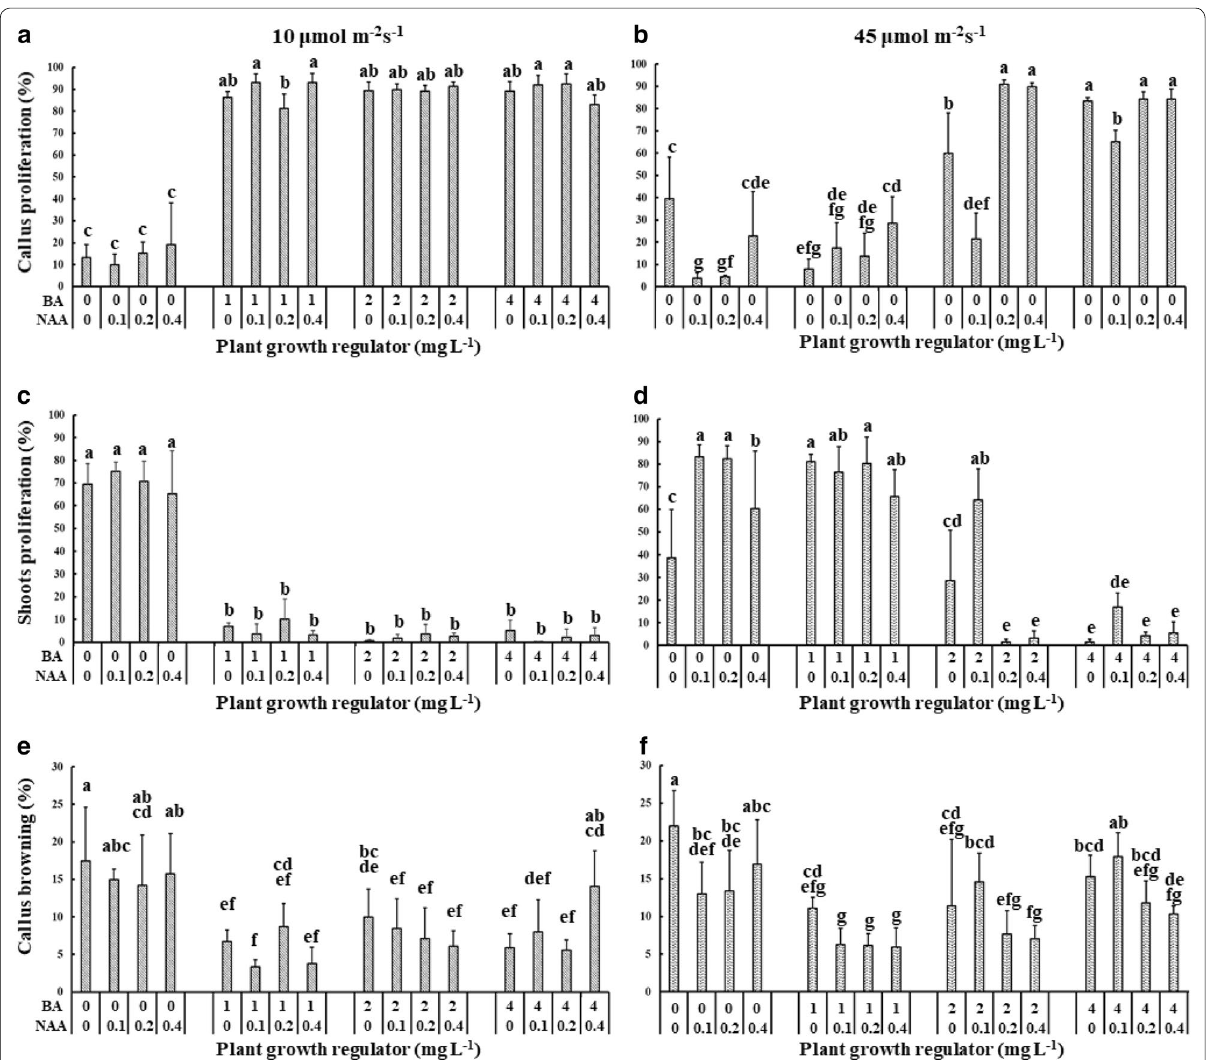
Fig. 2 Effect of light intensity on in vitro proliferation of Haworthia ‘Sansenjyu’. The percentage of callus proliferation ( a , b ), shoot proliferation ( c , d ) and callus browning ( e , f ) under 10 μmol m − 2 s − 1 or 45 μmol m − 2 s − 1 light